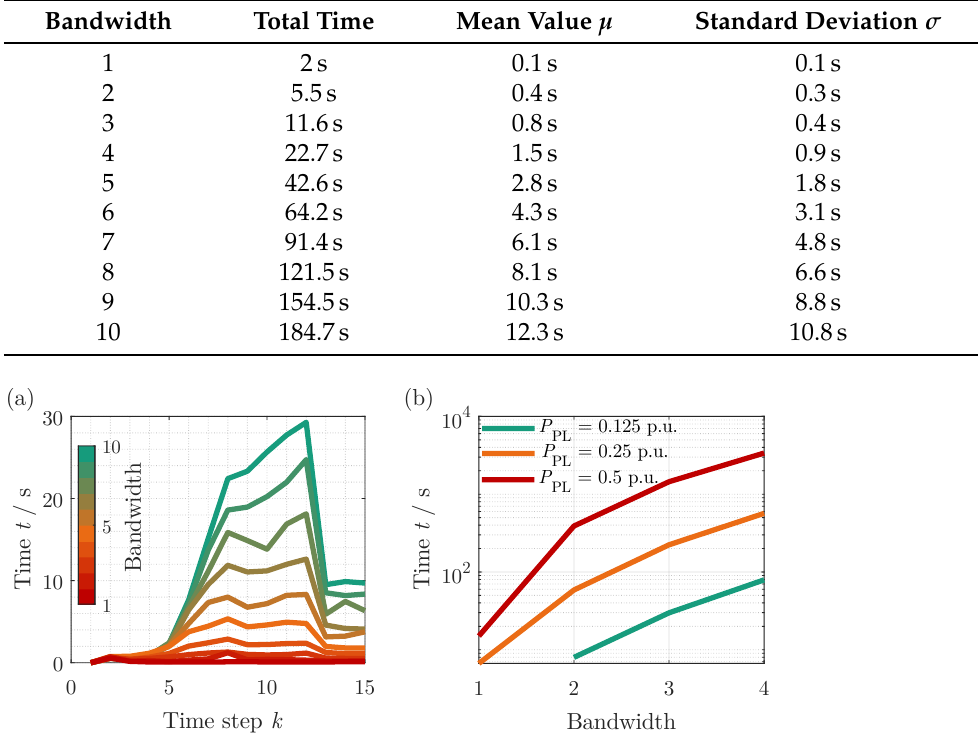
Table 1. Computing speed of the iDP for different bandwidths. The mean values and standard deviation are referred per time step.